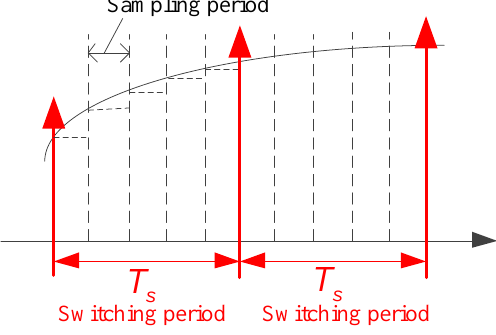
Figure 6. Schematic diagram for sampling in a switching cycle.